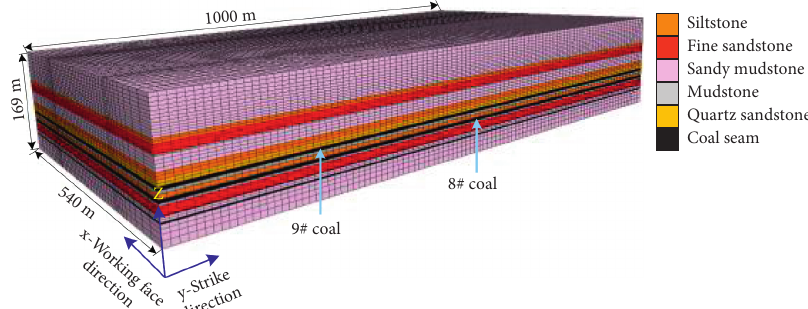
Figure 14: 3D numerical simulation model.